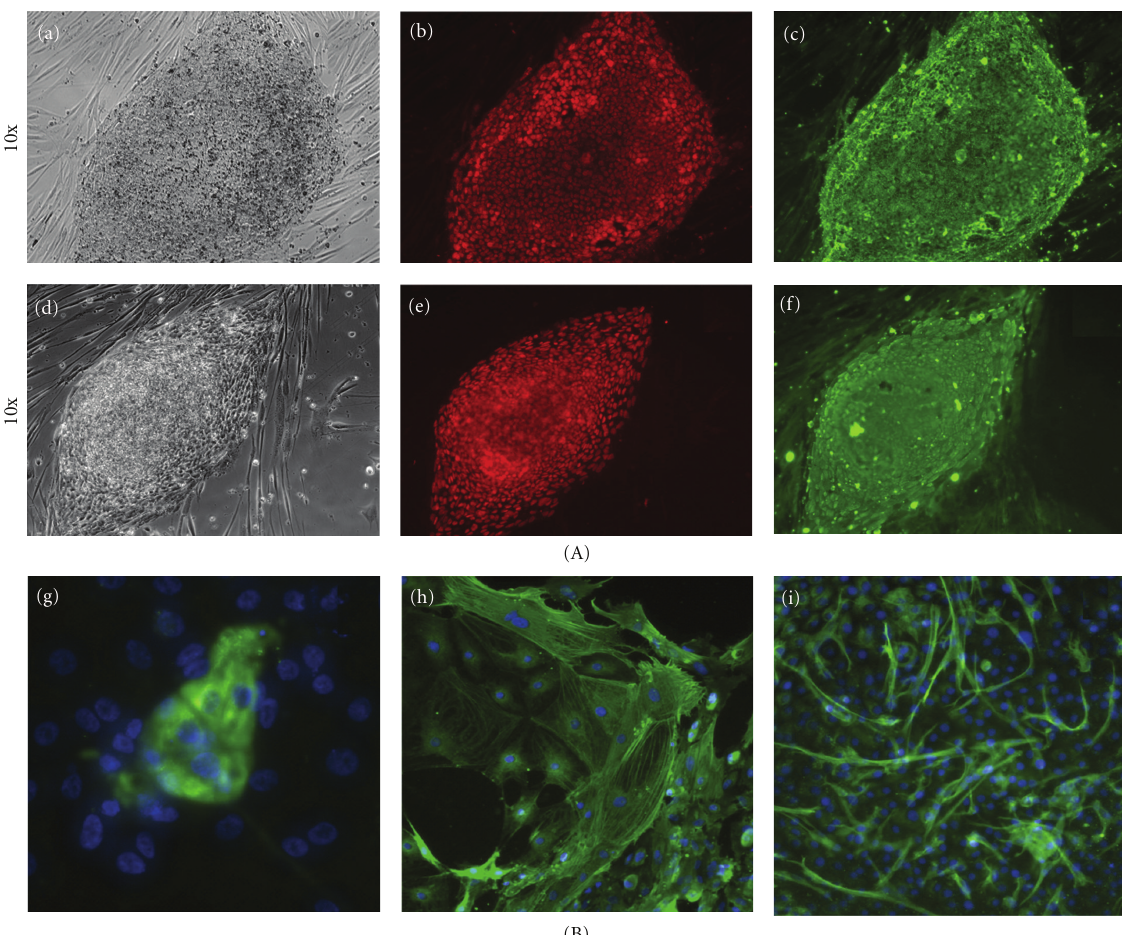
Figure 3: (A) Characterization and di ff erentiation of iPSC colonies generated on xeno-free conditions. Colonies were stained for pluripotent markers: NANOG (b), SSEA4 (c), SOX2 (e), Tra1-60 (f), and phase ((a) and (d)). (B) These colonies were di ff erentiated in vitro into embryoid bodies (EBs) comprising of the three embryonic germ layers: endoderm marker α fetoprotein (AFP) (g), mesodermal marker smooth muscle actin (SMA) (h), and ectoderm marker Beta 3-tubulin (Beta III)